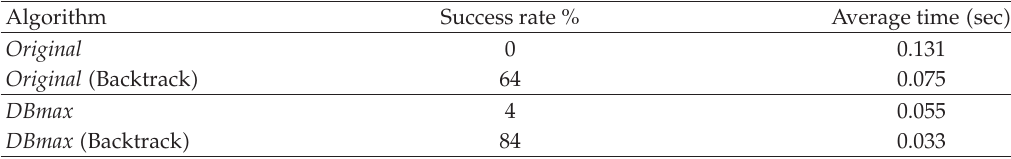
Table 2: Success rates and average times on SOCs.